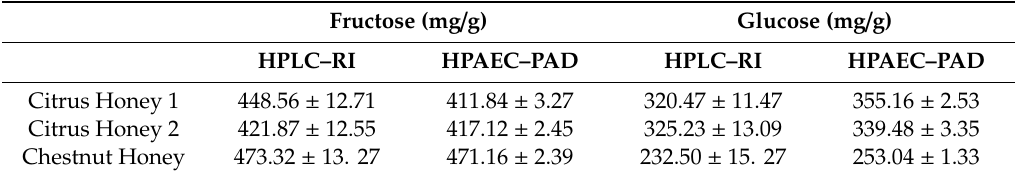
Table 3. Comparison of the amount of fructose and glucose in two citrus honey and one chestnut obtained using HPAEC–PAD and HPLC–RI methods.